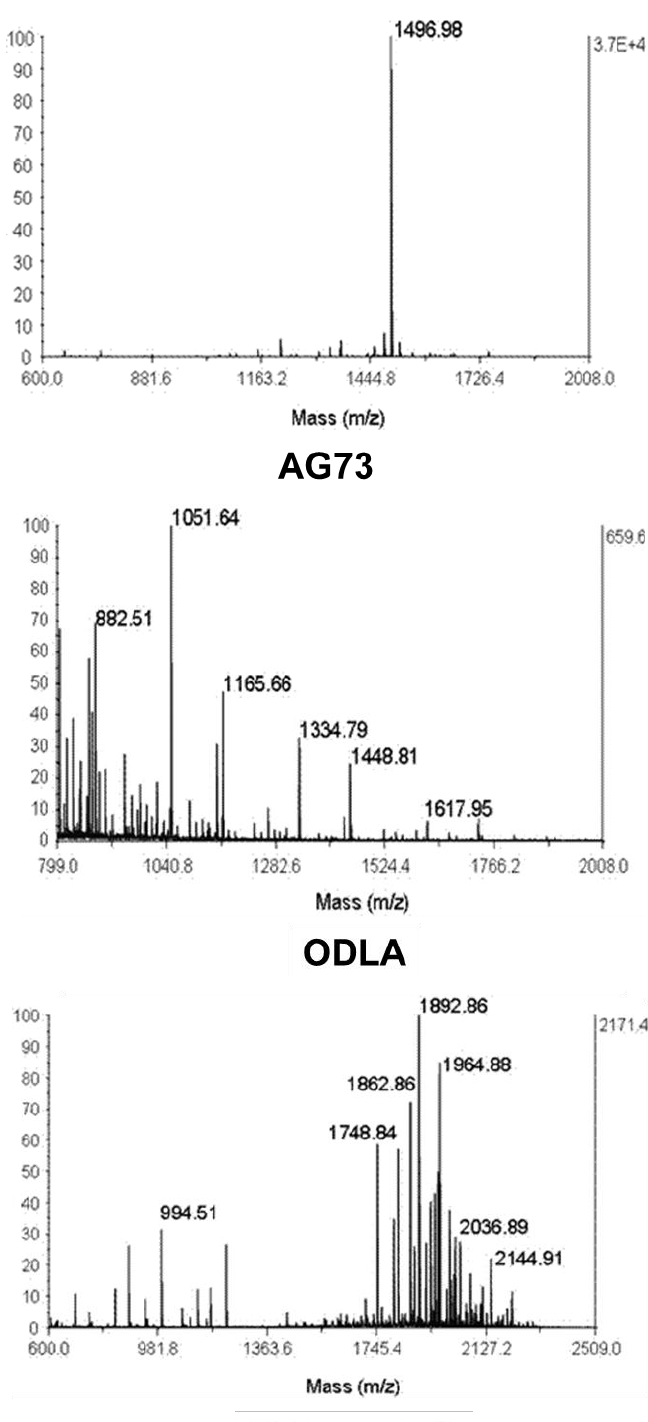
Figure S1. MALDI-TOF/MS spectra of AG73, ODLA, and ODLA-AG73 conjugate. Molecular weights were determined by MALDI-TOF/MS (4800 MALDI TOF/TOF Analyzer, Applied Biosystems, Foster City, CA, USA). The molecular weight of AG73, 1,496.98 Da, corresponds to the theoretical value. The molecular weight of ODLA ranges from about 700 to 1,750 Da, and after condensation with AG73 and ODLA, changes to about 1,750–2,150